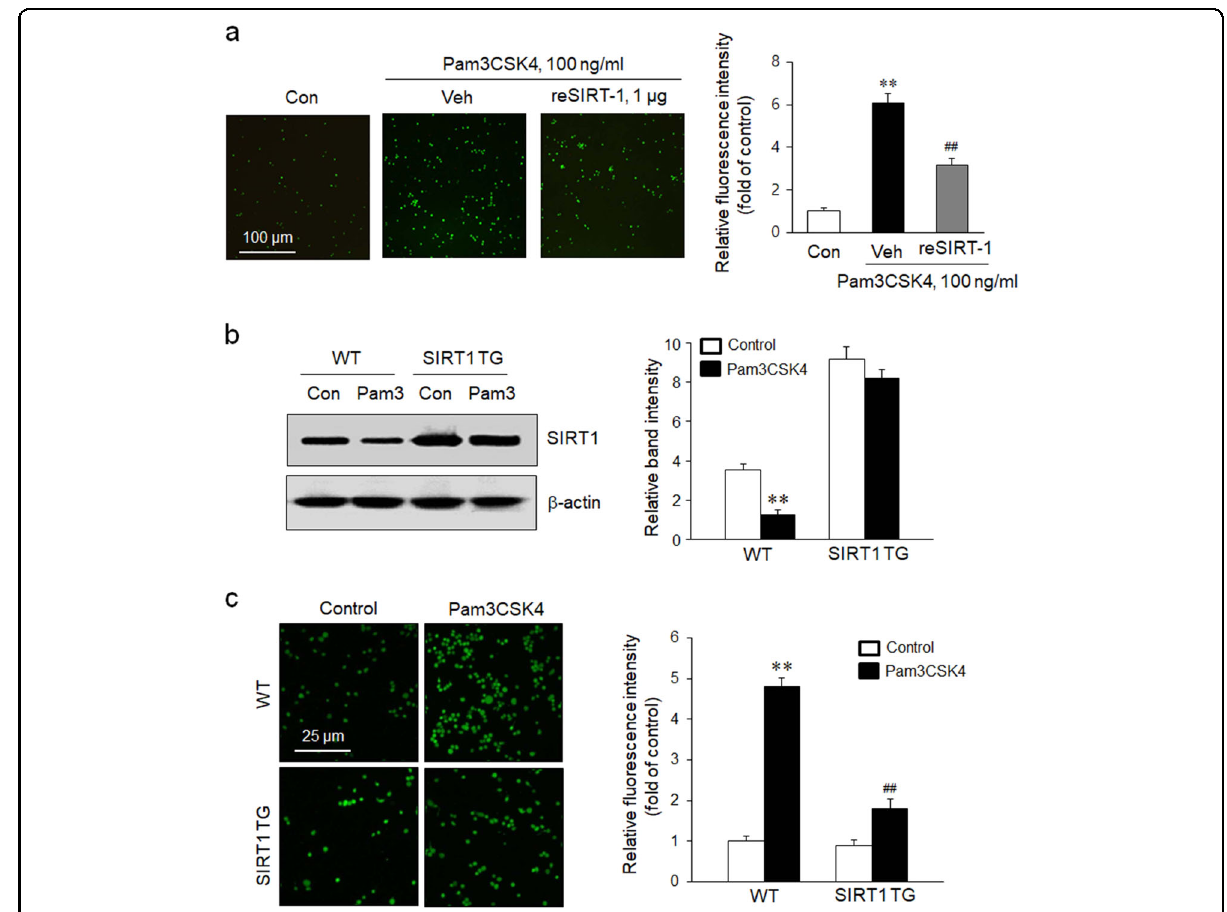
Fig. 3 The effects of SIRT1 on TLR2-induced monocyte adhesion to endothelial cells. a THP-1 cells were pretreated with recombinant SIRT1 (reSIRT1) for 1 h, stimulated with Pam3CSK4 for 24 h, and then cocultured with HUVECs for 2 h. Cells that adhered to HUVECs were visualized under a fl uorescence microscope. Quantitative data are presented as the means ± SEM of six independent experiments. **P < 0.01 compared with the control (Con); ## P < 0.01 compared with the vehicle (Veh). b Representative images of immunoblot showing SIRT1 levels in PBMCs isolated from WT and SIRT1 TG mice treated with 1 mg/kg Pam3CSK4 (Pam3) for 24 h. Quantitative data are presented as the means ± SEM of four independent experiments. **P < 0.01 compared with the corresponding control. c PBMCs isolated from WT and SIRT1 TG mice treated with 1 mg/kg Pam3CSK4 for 24 h were cocultured with HUVECs for 2 h. Cells that adhered to HUVECs were visualized under a fl uorescence microscope, and quantitative data shown in the right panel are presented as the means ± SEM of six independent experiments. **P < 0.01 compared with the corresponding control; ## P < 0.01 compared with the corresponding value for WT